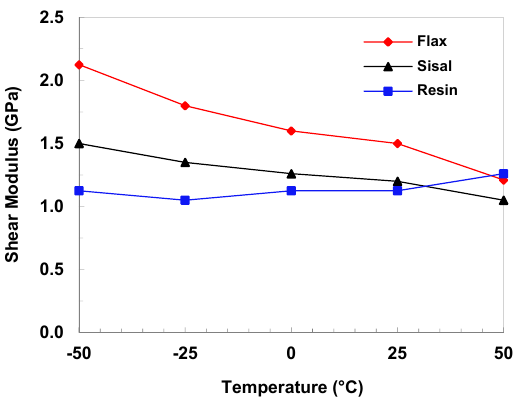
Figure 6. Shear modulus of flax and sisal fibres compared with the shear modulus of the matrix.